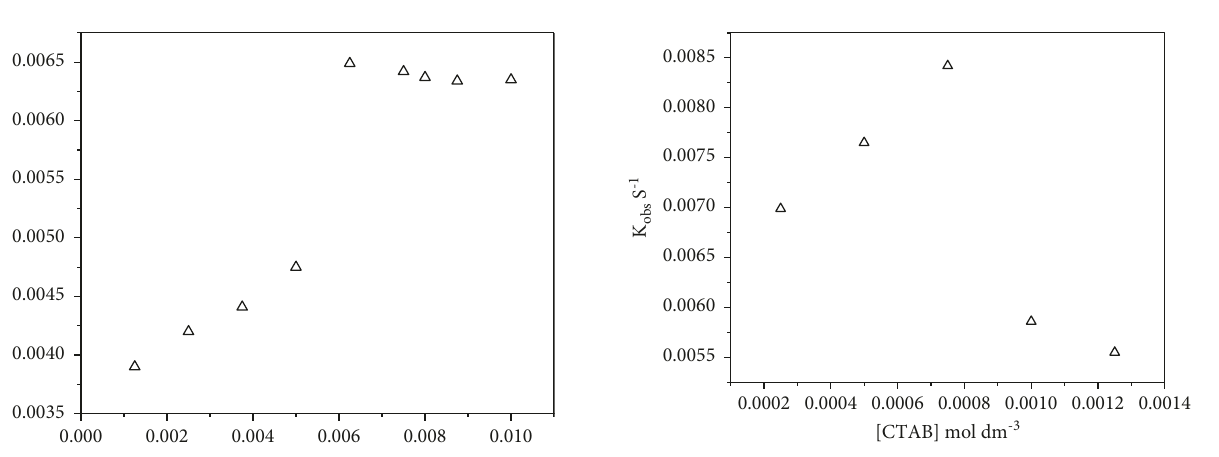
Figure 8: k obs vs. [CTAB], at the following reaction conditions: [Maltose] � 0.030moldm − 3 , [Ce (IV)] � 0.0030moldm − 3 , and [H 2 SO 4 ] � 0.40 moldm − 3 at 293K.